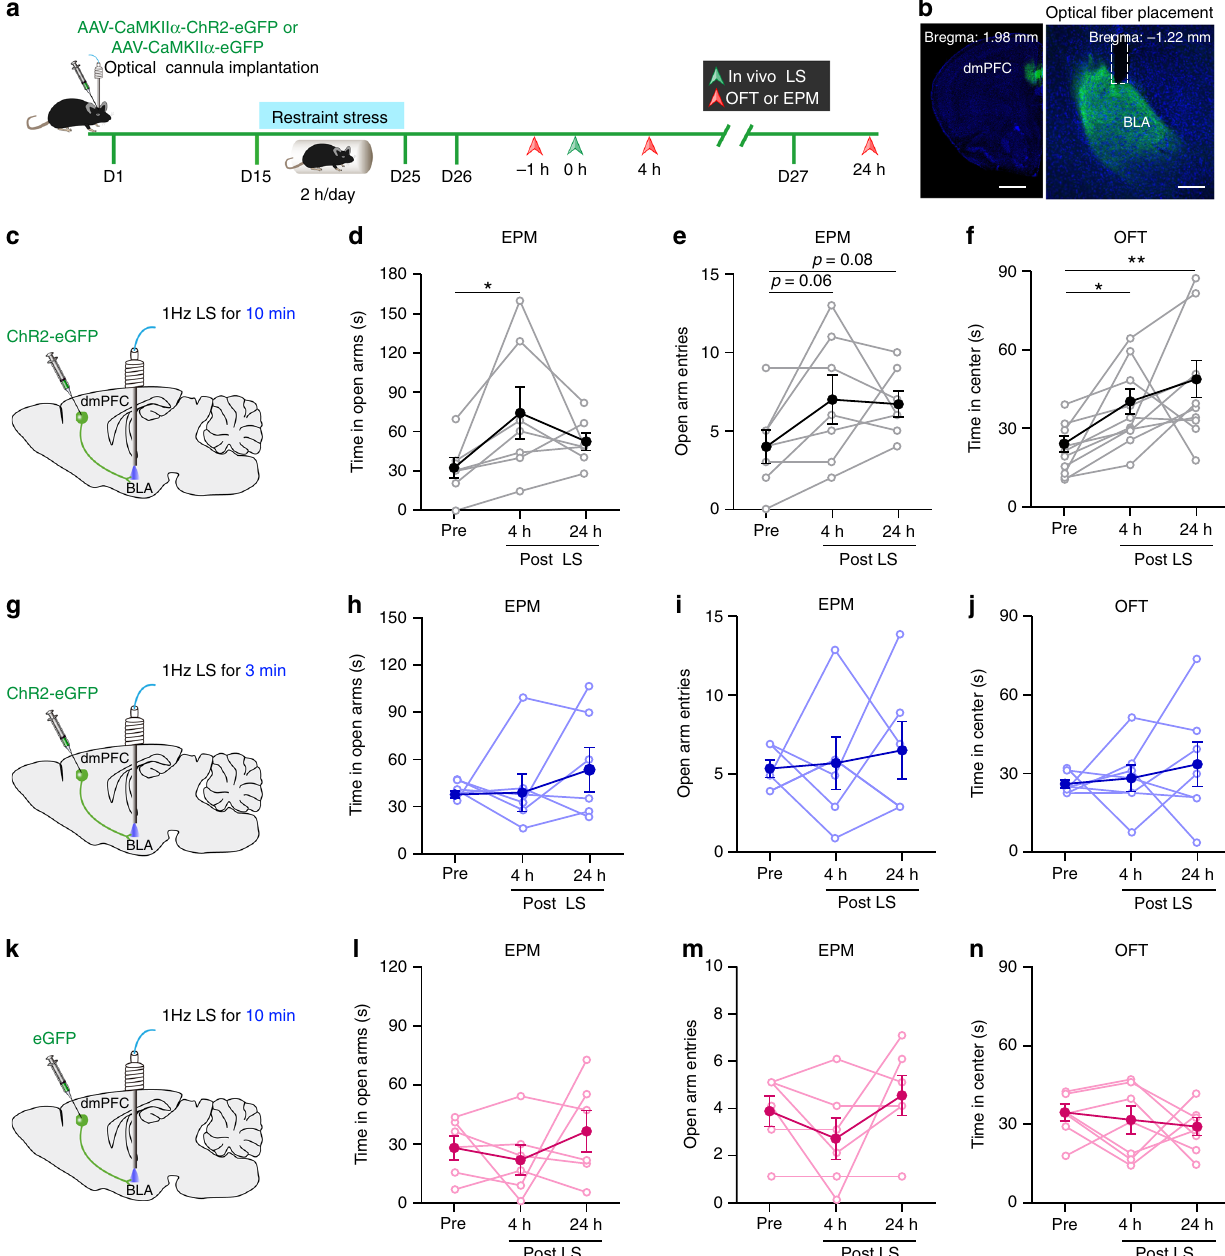
Fig. 7 Activation of dmPFC-to-BLA pathway alleviates the increased anxiety-like behavior by chronic stress. a Schematic showing the experimental procedures. b Representative image showing injection of ChR2-carrying AAV in dmPFC (left) and the cannula implantation onto BLA (right, dotted line). Scale bar: 500 (left) and 100 (right) μ m. c Schematic illustration of injection of ChR2-carrying AAV in dmPFC and bilateral cannula implantation with optic fi bers onto BLA. LS (1 Hz, 10 min) was delivered to BLA. d , e EPM open-arm time ( d ) and entries ( e ) measured pre- and post-LS. n = 7. f OFT time in center measured pre- and post-LS. n = 10. g Same as in c except that 3-min LS were delivered to CRS mice. h , i EPM open-arm time ( h ) and entries ( i ) measured pre- and post-LS. CRS mice, n = 6. Note that there were two data points in i being overlapped throughout the experiment. j OFT time in center measured pre- and post-LS. CRS mice, n = 7. k Same as in c except that the AAV vectors containing eGFP only were injected into dmPFC. l , m EPM open-arm time ( l ) and entries ( m ) measured pre- and post-LS. CRS mice, n = 6. n OFT time in center measured pre- and post-LS. CRS mice, n = 7. Data are presented as mean ± SEM. Statistics are shown in Supplementary Table 1. * p < 0.05. ** p < 0.01. Source data are provided as a Source Data fi When necessary, the red (Alexa Fluor 555) fl uorescent retrogradely transported anterogradely traveling AAV serotype 2/8 carrying ChR2 fused with eGFP under beads (RetroBeads, Luma fl uor Inc., Durham, NC, USA) were co-injected with the the control of the CaMKII α promoter (AAV 2/8 -CaMKII α -hChR2(H134R)-eGFP, ChR2-carrying AAV into the dmPFC, vmPFC, or vHPC to label the putative 4.72× 10 12 infectious unitsmL − 1 ) (Obio Technology, Shanghai, China) were dmPFC ↔ BLA PNs, vmPFC ↔ BLA PNs, or vHPC ↔ BLA PNs in BLA. Injection bilaterally injected into the dmPFC (0.35 μ L per hemisphere; stereotaxic coordi- was performed using glass micropipettes with their tip diameters of ∼ 10 – 20 μ m nates from bregma: anterior/posterior, 1.94 mm; medial/lateral, ±0.35 mm; dorsal/ (pulled with the Narishige PC-10 puller, Japan) mounted on 10- μ L Hamilton ventral, − 2.5mm), vmPFC (bregma coordinates: anterior/posterior, 1.94mm; Microlitre syringe (Hamilton Co., Reno, NV, USA). The AAV and Retrobeads were medial/lateral, ±0.35 mm; dorsal/ventral, − 3.1 mm) or vHPC (bregma coordinates: delivered at a rate of 150nL min − 1 using a stereotactic injector (QSI, Stoelting, anterior/posterior, − 3.06mm; medial/lateral, ±3.4 mm; dorsal/ventral, − 3.8 mm).